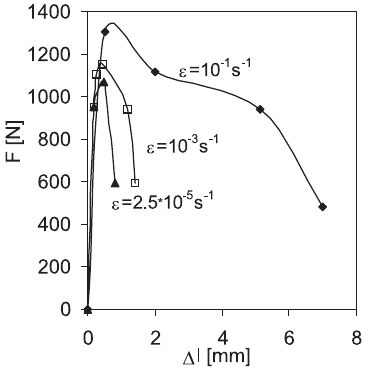
Fig. 9: Stress-strain dependences at 723 K ( ♦ ε ͘ = 10 − 1 s − 1 ,